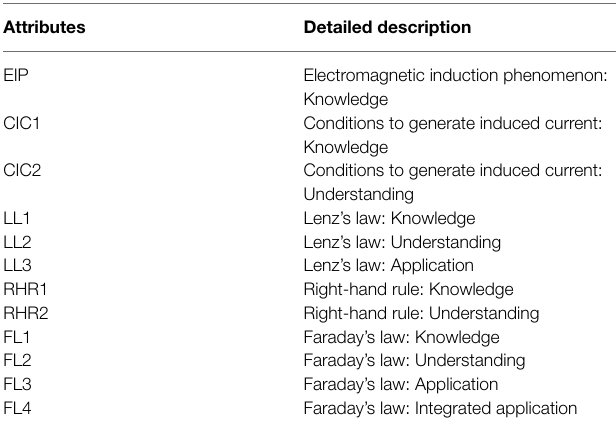
TABLE 1 | Multi-level